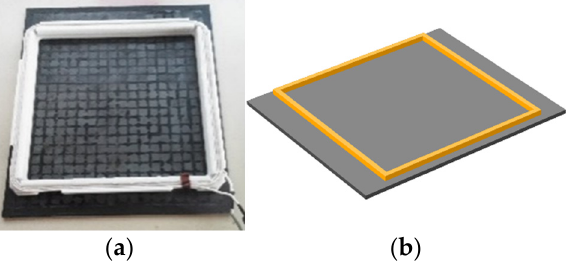
Figure 6. Coil form of the Twizy WPT system, ( a ) picture of the primary coil, ( b ) coil modeled by COMSOL